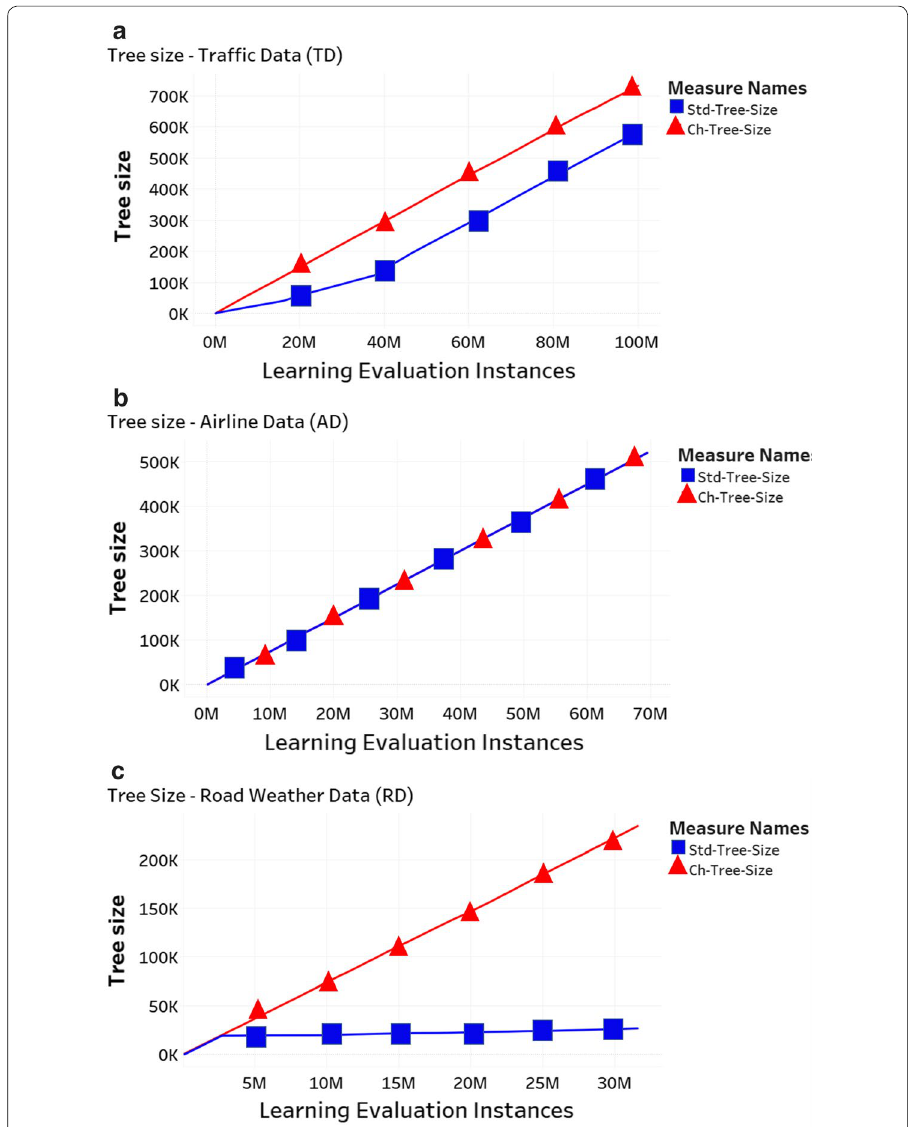
Fig. 6 Tree size of Hoeffding bound (std-time) and Chernoff bound